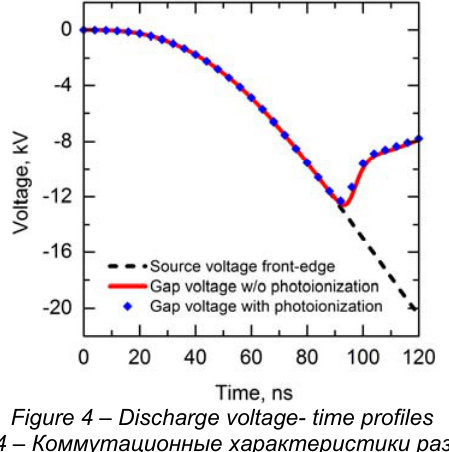
Figure 4 – Discharge voltage- time profiles Рис . 4 – Коммутационные характеристики